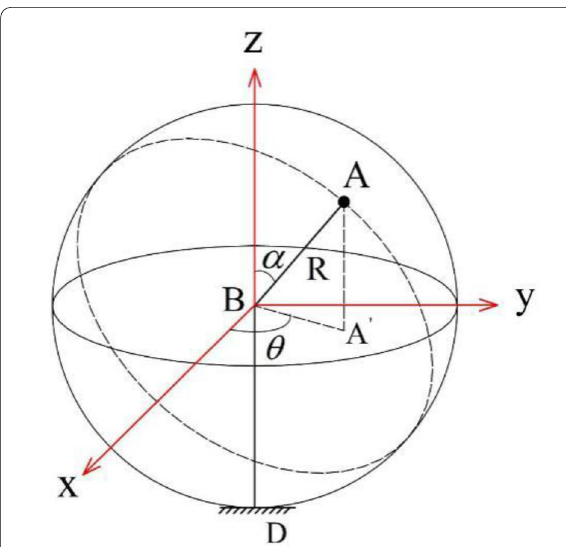
Figure 12 The thrust F AN under mechanism deformation